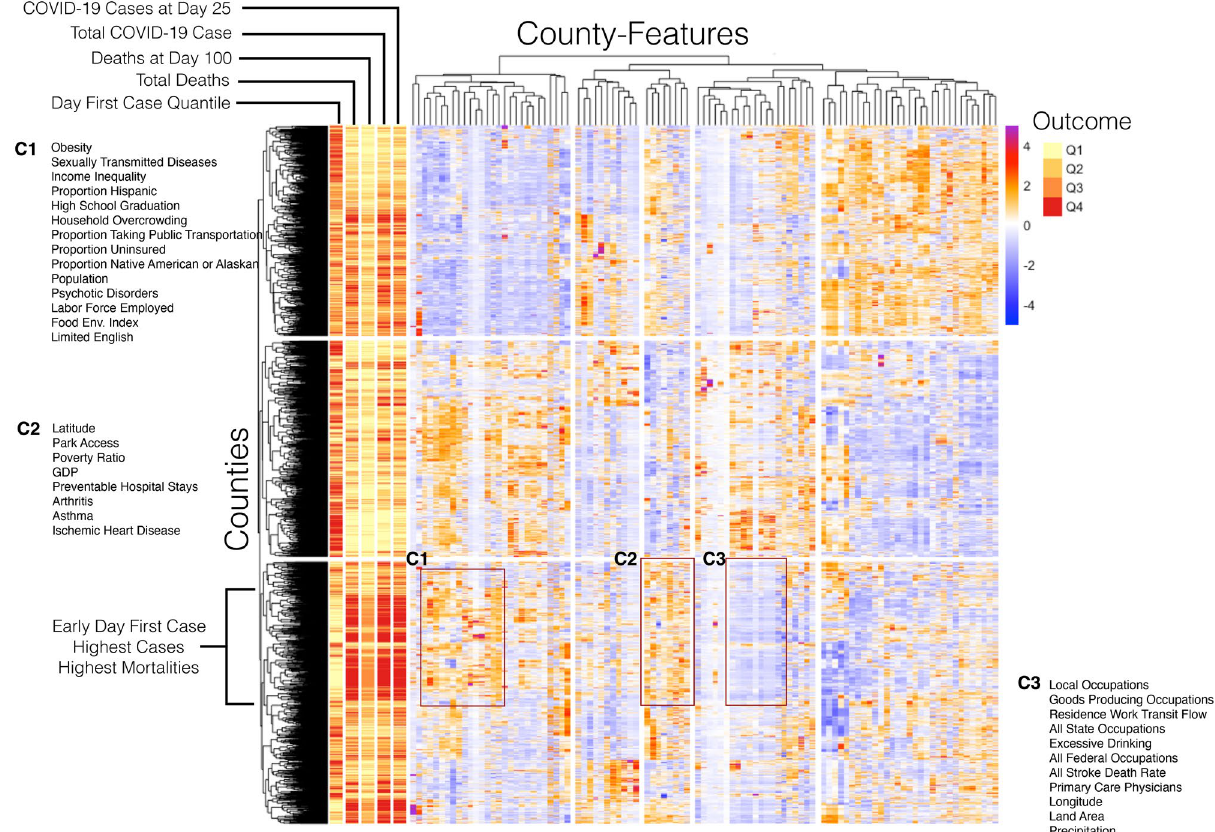
Figure 1. COVID-19 heatmap visualization of the distribution of county-level data. The rows represent counties clustered by the dendrogram and the columns are features of the counties which are also clustered by similarity. Red coloration indicates higher values (up to a z-score of 4) and blue coloration indicates lower values (− 4). The column bars on the left are outcomes, categorized by quantiles. The sections marked by C1, C2, and C3 show similar high or low features of counties in this region which have early COVID-19 appearance and high transmission and mortalities. Figure was created using pheatmap version 1.0.12 28